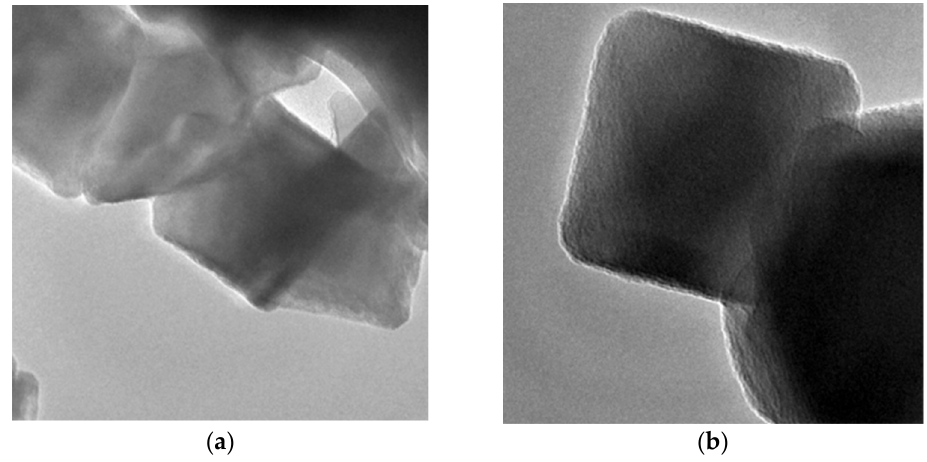
Figure 1. ( a ) Scanning electron microscopy (SEM) and ( b ) transmission electron microscopy (TEM) images of Fe 3 O 4 nanoparticles. Reprinted/adapted with permission from [52]. 2023, Springer Nature.